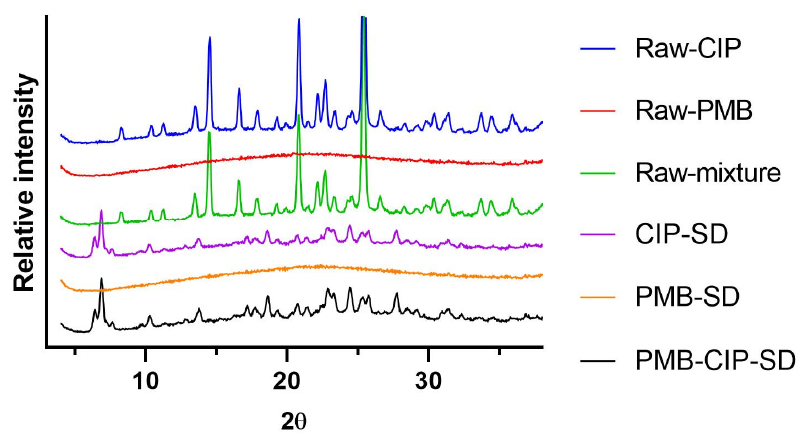
Figure 3. Powder diffraction patterns of raw CIP, raw PMB, physical mixture, CIP − SD, PMB − SD and PMB − CIP −